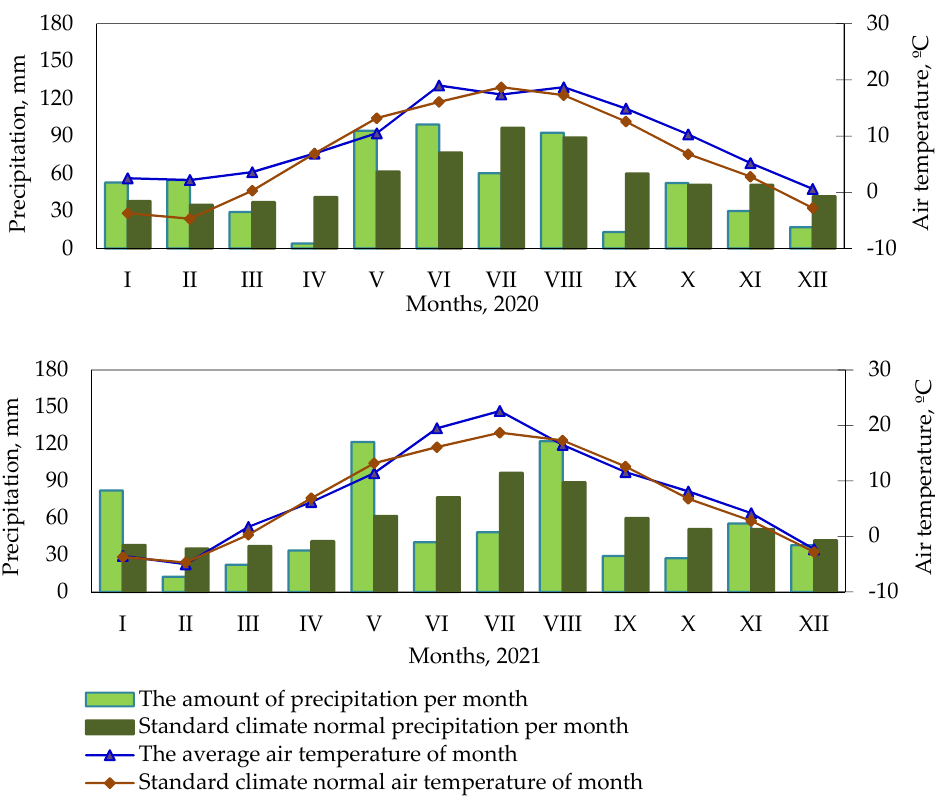
Figure 2. Meteorological conditions during the experimental period, Kaunas Weather Station.